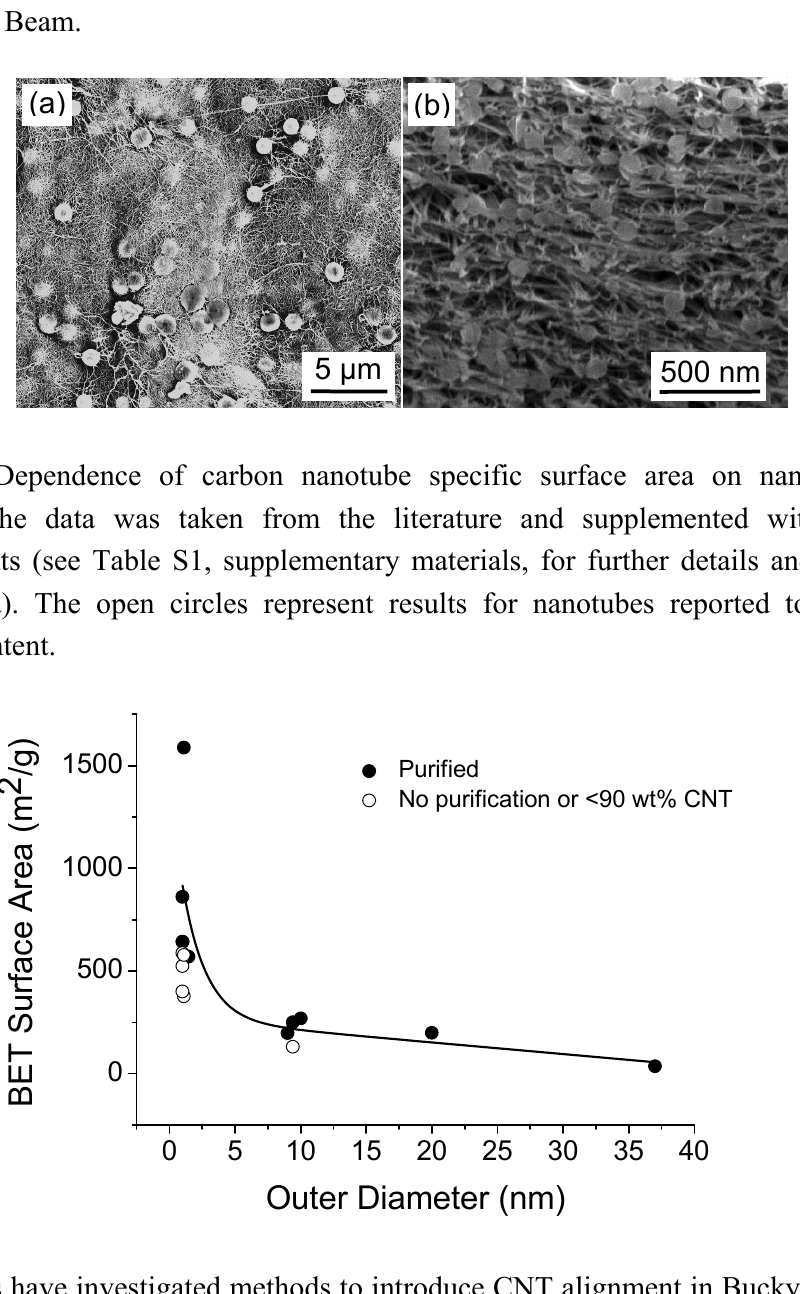
Figure 6. SEM images showing (a) the surface and (b) a cross section (52° sample tilt) of a Bucky-paper formed from a mixed dispersion of PS beads and multi-walled carbon nanotubes (5 kV, 5 mm working distance). The PS beads in (a) and (b) had 1 μ m and 100 nm diameters, respectively. The cross-section was formed by milling with a Gallium Focused Ion Beam.